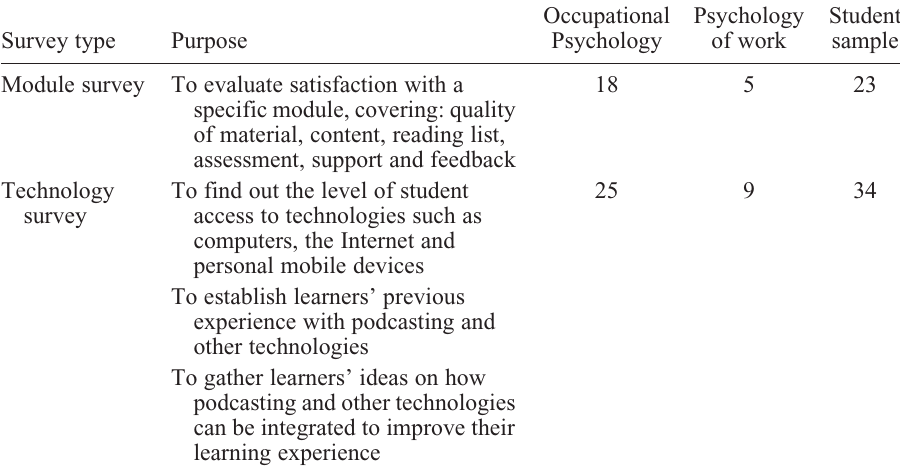
Table 4. Sample distribution across cohorts.